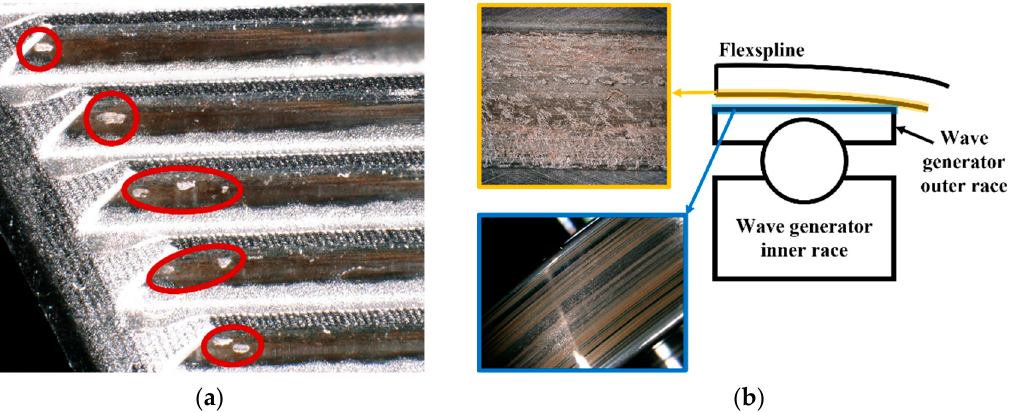
Figure 4. ( a ) Pitting on the flexspline teeth of gear A. ( b ) Adhesive wear marks on the wave gener ‐ ator and the flexspline of gear A.